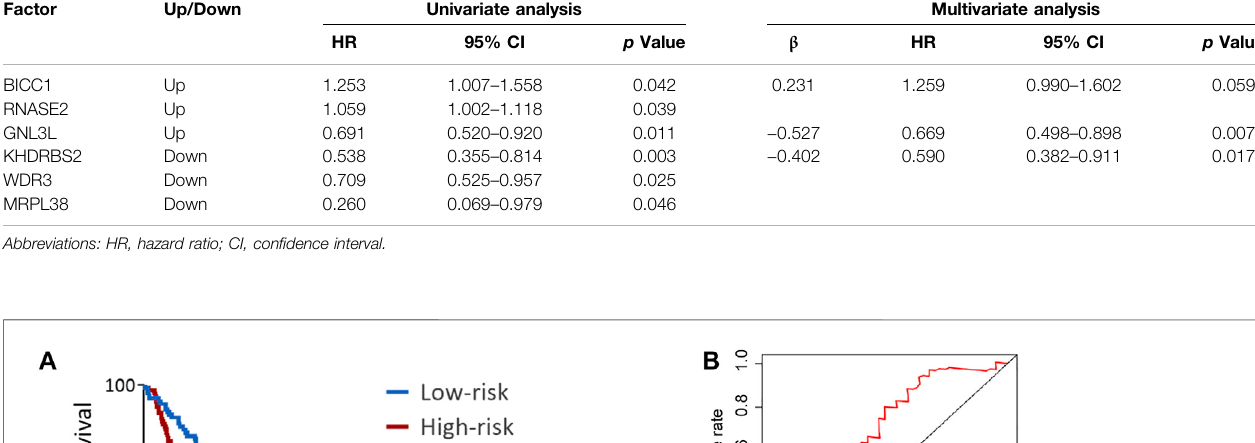
TABLE 2 | 3 prognosis-associated hub RBPs identi fi ed by univariate and multivariate Cox regression analysis.